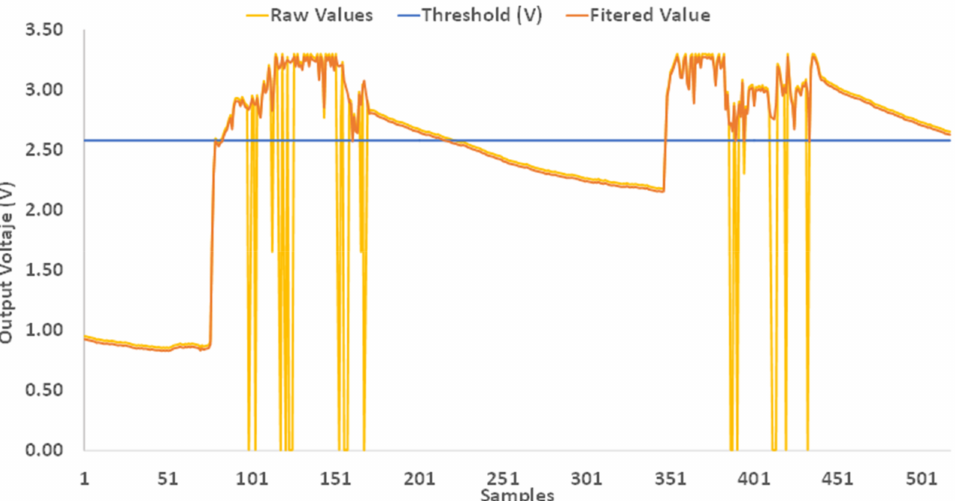
Figure 21. Measurement of water detection by the